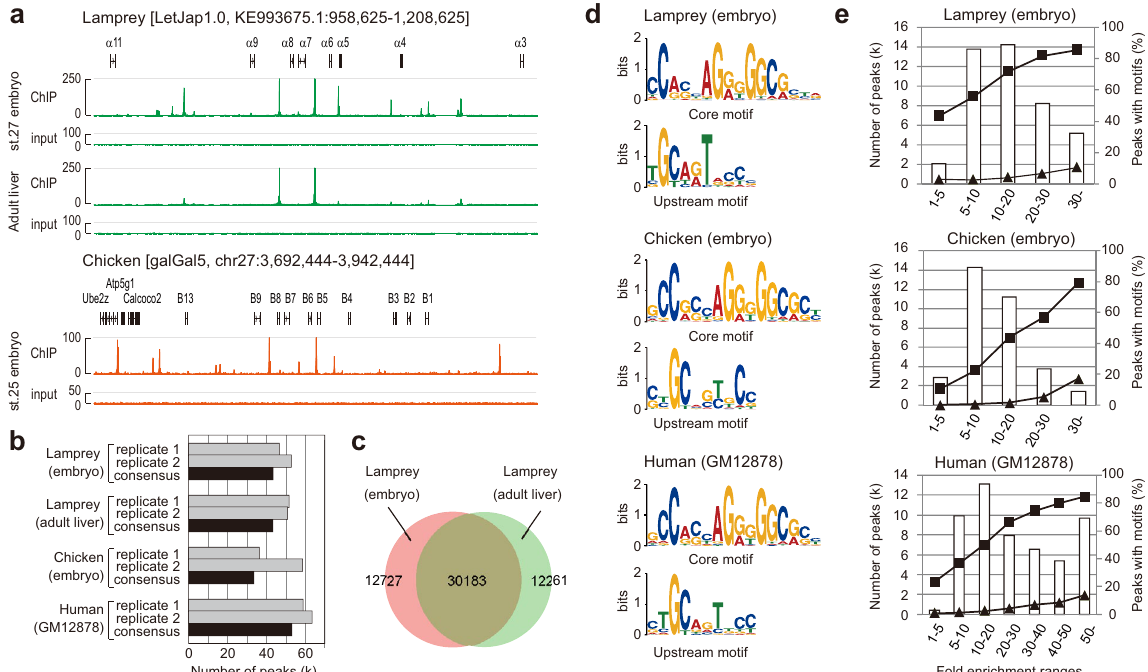
Figure 3. ChIP-seq peaks and binding motifs in lamprey, chicken and human cells. ( a ) ChIP-seq results for lamprey and chicken CTCF. Shown are the lamprey Hox α cluster and chicken Hox B cluster. ( b ) Numbers of peaks identified by MACS2. The “consensus peaks” (black bar) were identified by taking an intersect of peaks called in each replicate and in the merged replicates (see Materials and Methods for details about peak selection). ( c ) Overlap of consensus peaks in the lamprey embryo and adult liver tissue. ( d ) CTCF core and upstream motifs identified by MEME. The motifs were identified in two parts and are almost identical between the different species analyzed (also see Supplementary Fig. S11). ( e ) Peaks in various fold enrichment ranges harboring the core motif and core + upstream motifs. Numbers of ChIP-seq peaks are shown with white bars. Proportions of peaks containing a core motif ( ▪ ) and those containing a core + upstream motif ( ▴ ) are indicated as lines.